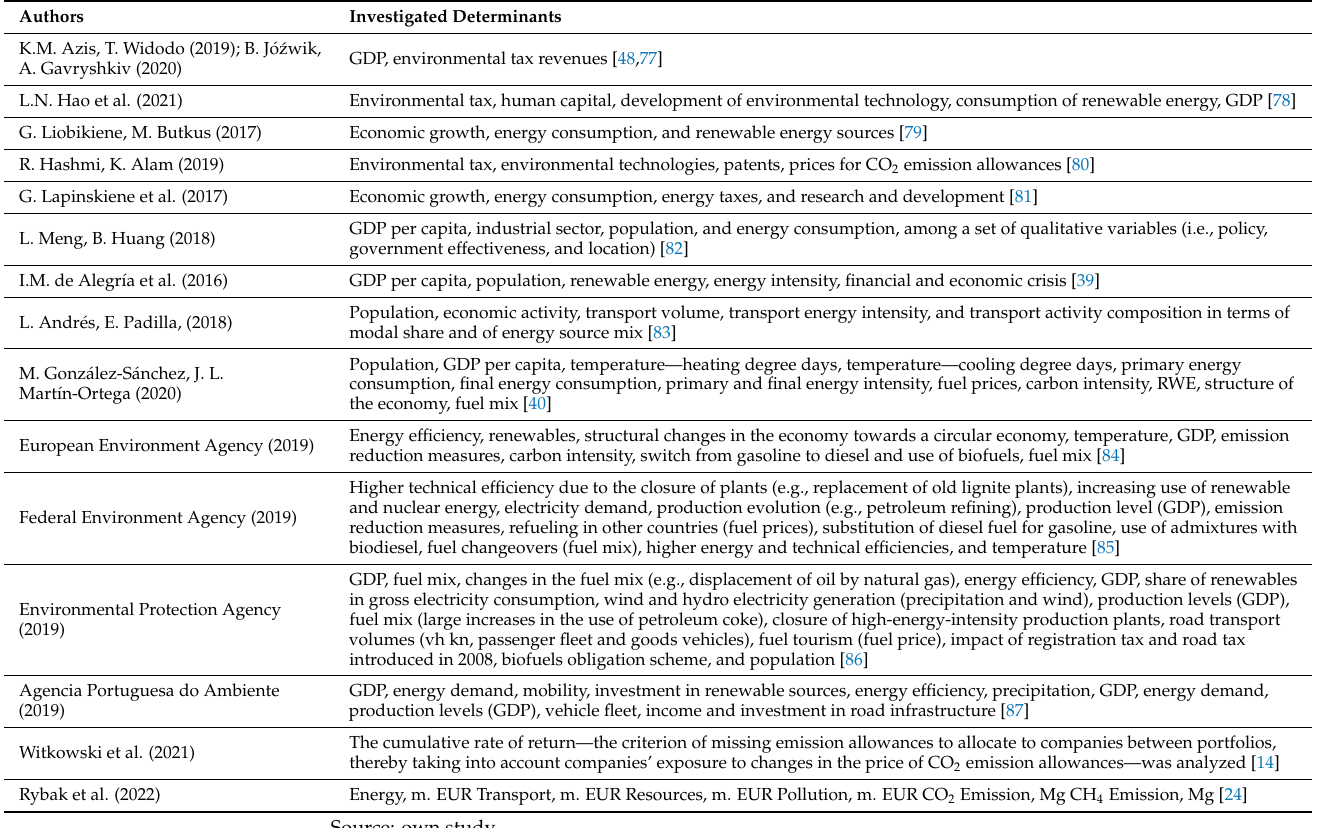
Table 1. Determinants of greenhouse gas emissions—literature